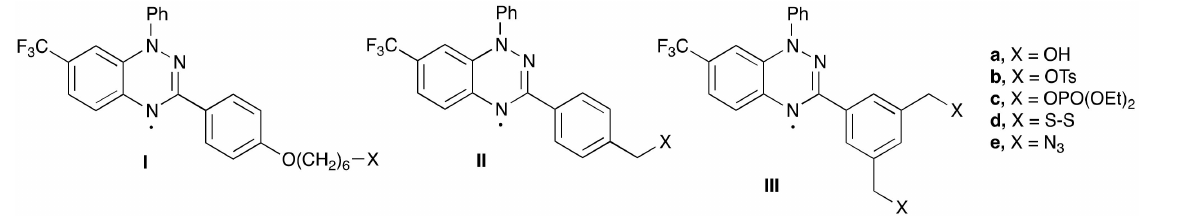
Figure 2. The structure of three types of radicals ( I – III ) for molecular grafting. Reported compounds: Ia – Ie , IIa – IId , IIIa and IIIb